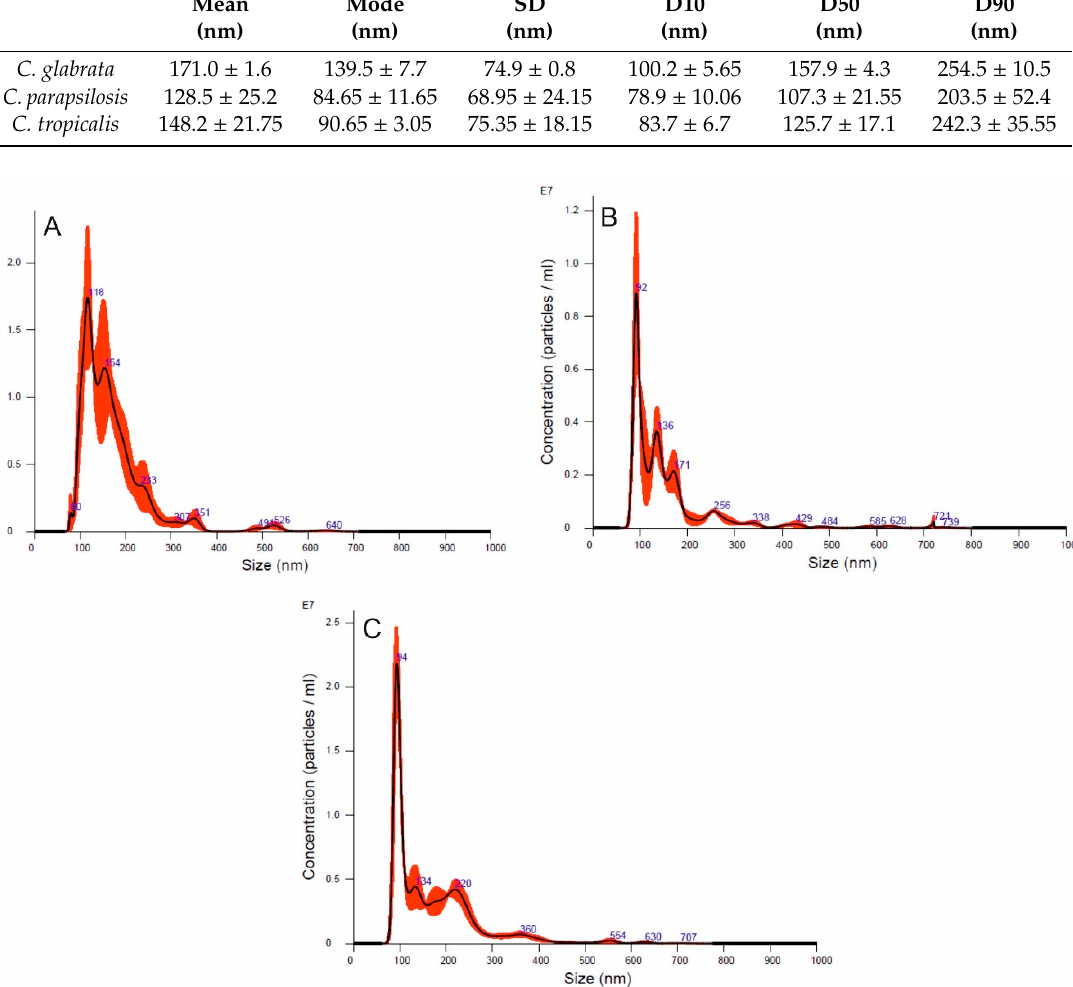
Figure 1. NTA particle size distribution analysis of C. glabrata ( A ), C. parapsilosis ( B ) and C. tropicalis ( C ) EVs. Representative histograms of the average size distribution (black line) from three measurements of a single sample. Red areas specify the standard deviation (SD) between measurements and blue numbers indicate the maxima of individual peaks.